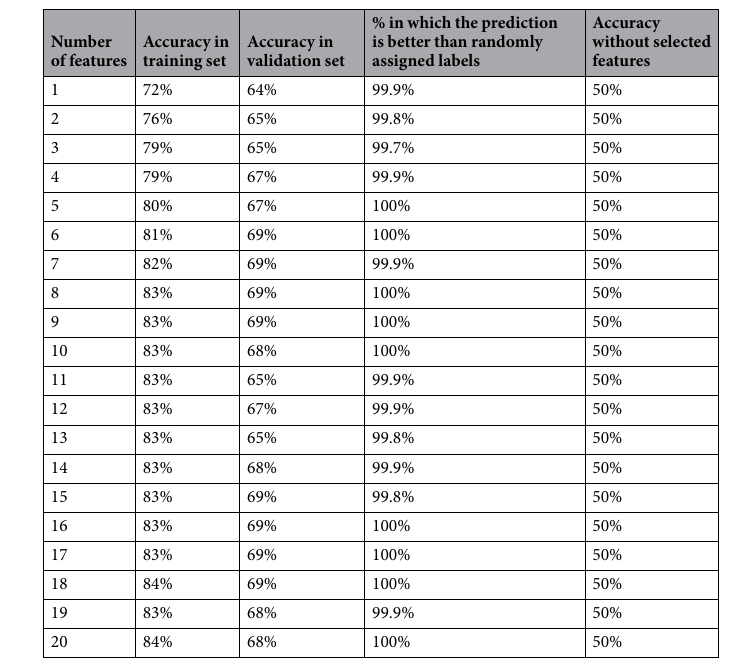
Table 2. Summary of the extracted features for the second analysis with training and validation sets for ERP data. All accuracy values are